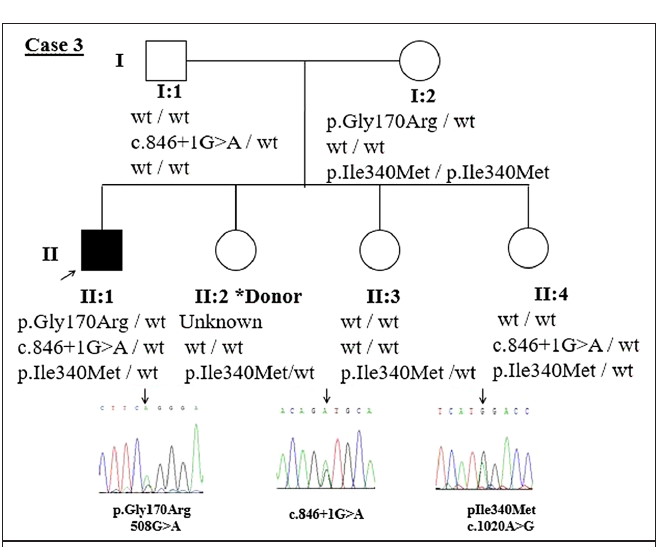
Figure 2. Sequence results of Case 3.